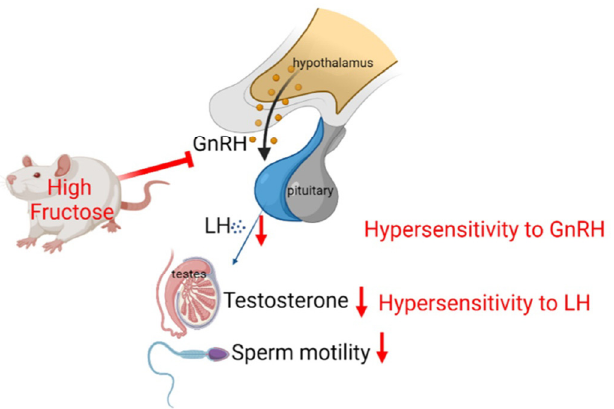
Figure 8. Schematic representation of the mechanisms by which a high-fructose diet impairs male reproductive function following an alternation of the HPG axis.